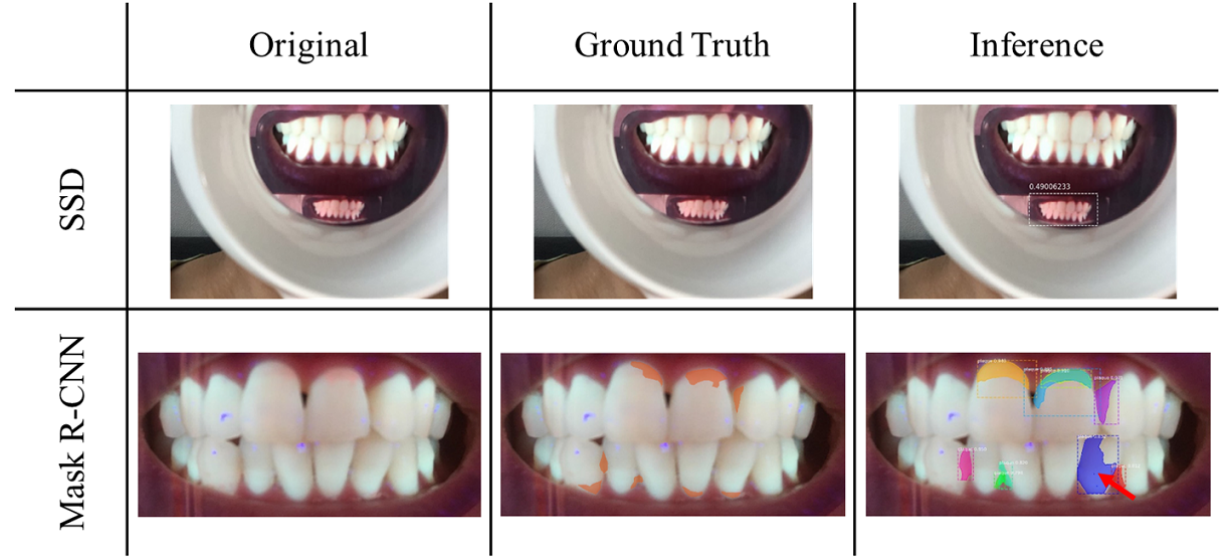
Figure 6. Representative poor results of each deep learning algorithm.